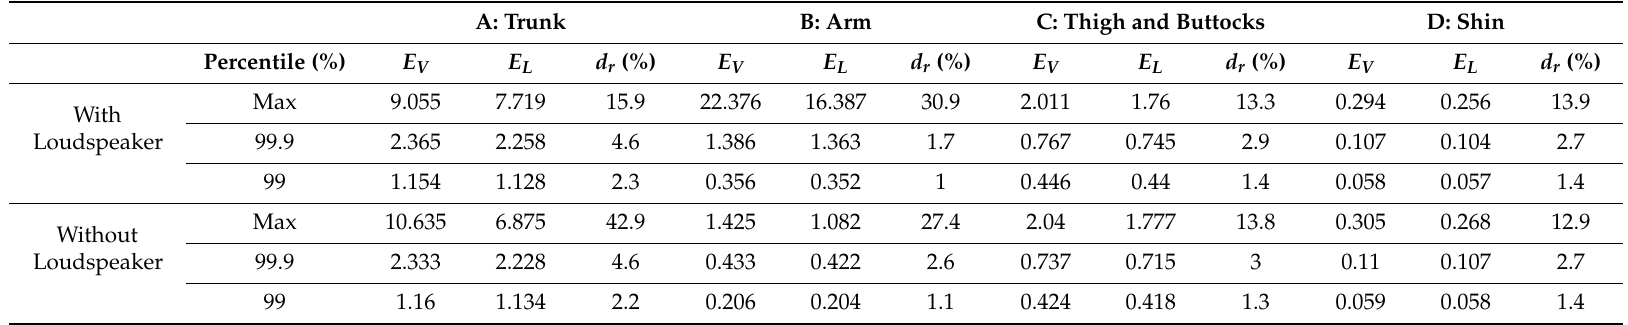
Table 4. Averaging values of in situ electric field strength (mV / m) in di ff erent driver body measurement positions with and without the loudspeakers (both woofer and tweeter) in the aluminum